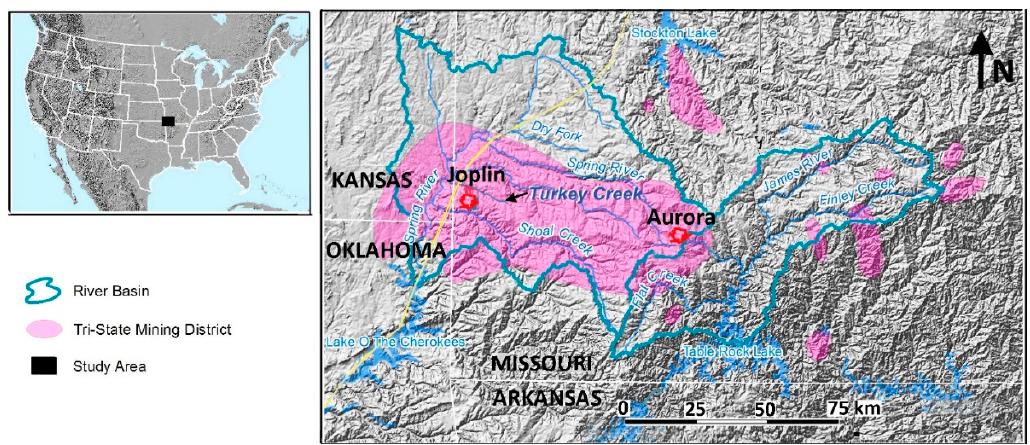
Figure 1. Extent of the Tri-State Mining District (TSMD) shaded in pink, and the locations of Joplin and Aurora, Missouri. Inset shows the TSMD within the United States.